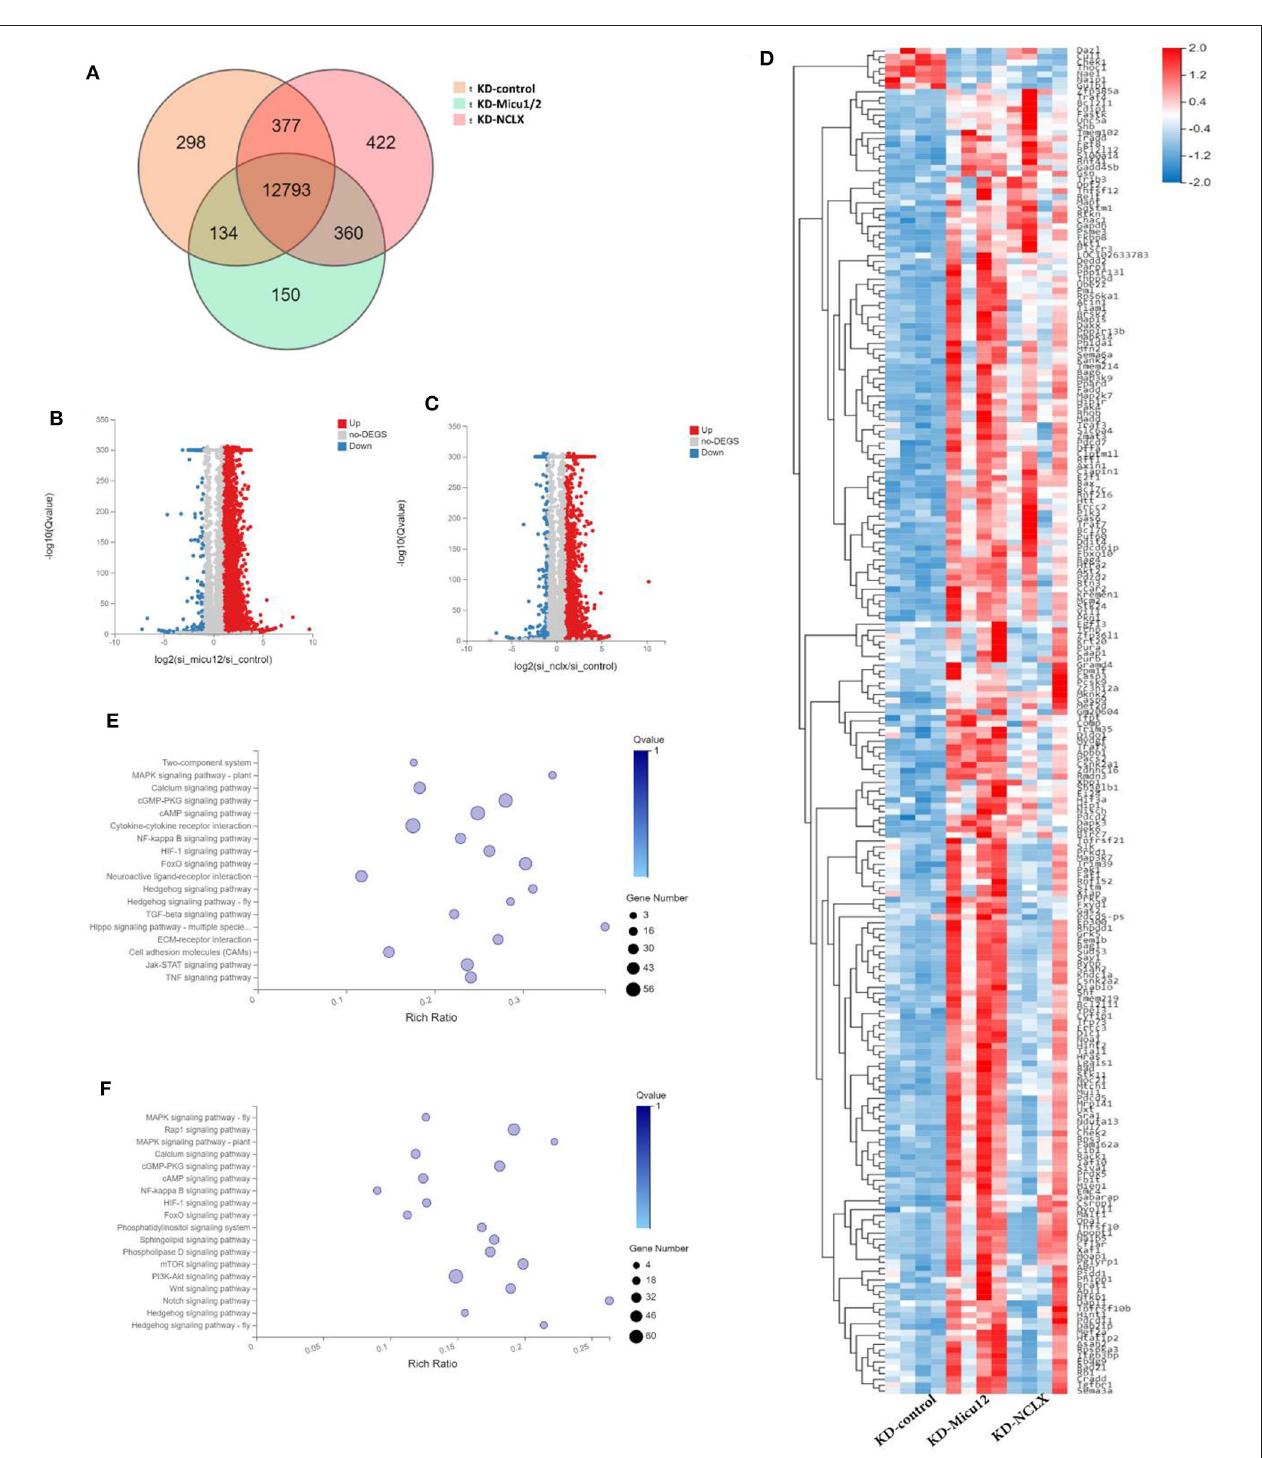
FIGURE 4 | Gene expression changes upon KD-Micu1/2, KD-NCLX. (A) VENN showing differential genes in KD-Micu1/2 and KD-NCLX GV oocytes. (B) Volcano plot showing upregulated (red) and downregulated (blue) genes in KD-Micu12 GV oocytes. (C) Volcano plot showing upregulated (red) and downregulated (blue) genes in KD-NCLX GV oocytes. (D) Heatmap showing average expression for all replicates and relative expression between replicates for genes with cell cycle, division functions and mitochondrial functions (based on GO-term). (E) Go cellular component showing the biological process and function of the differential genes participated in KD-Micu1/2 GV oocytes (based on KEGG enrichment analysis). (F) Go cellular component showing the biological process and function of the differential genes participated in KD-Micu1/2 GV oocytes (based on KEGG enrichment analysis).